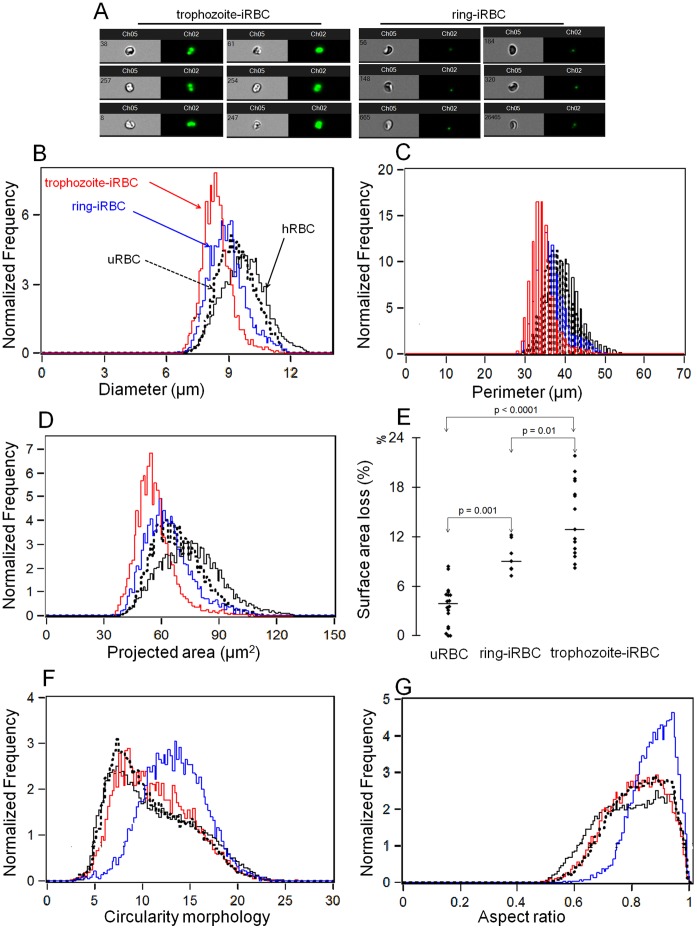
Geometry and functional alterations of uninfected or P. falciparum infected red blood cells.Analysis of uninfected (uRBCs or hRBCs) or infected (ring-iRBCs, age <9 hours; or trophozoite-iRBCs, age: 30 to 35 hours) cell dimension and morphology using ImageStream technology (A–G). Before acquisition, parasite nucleus was labeled with Hoechst 33342 (diluted 1∶1000; Invitrogen, Carlsbad, CA; LSR; BD Biosciences, San Jose, CA), allowing differentiation of infected from uninfected co-culture RBCs. For each population of Pf-iRBCs, more than 10000 images were collected and analyzed with ImageStream technology. Captured images of infected RBCs are displayed in (A). There is a shift toward lower values of the distribution of iRBC diameter, perimeter and projected surface area, which increases with parasite maturation (B–D). Ring-iRBCs display a more pronounced surface area loss than uninfected co-culture RBCs (uRBC), but smaller than trophozoite-iRBCs (E). Circularity morphology and/or aspect ratio of iRBCs were increased compared to healthy RBCs (hRBCs) (F–G). The surface area loss of Pf-iRBCs or uRBCs = [1– (mean values of projected surface area of iRBCs or uRBCs/mean values of projected surface area of hRBC)]*100.